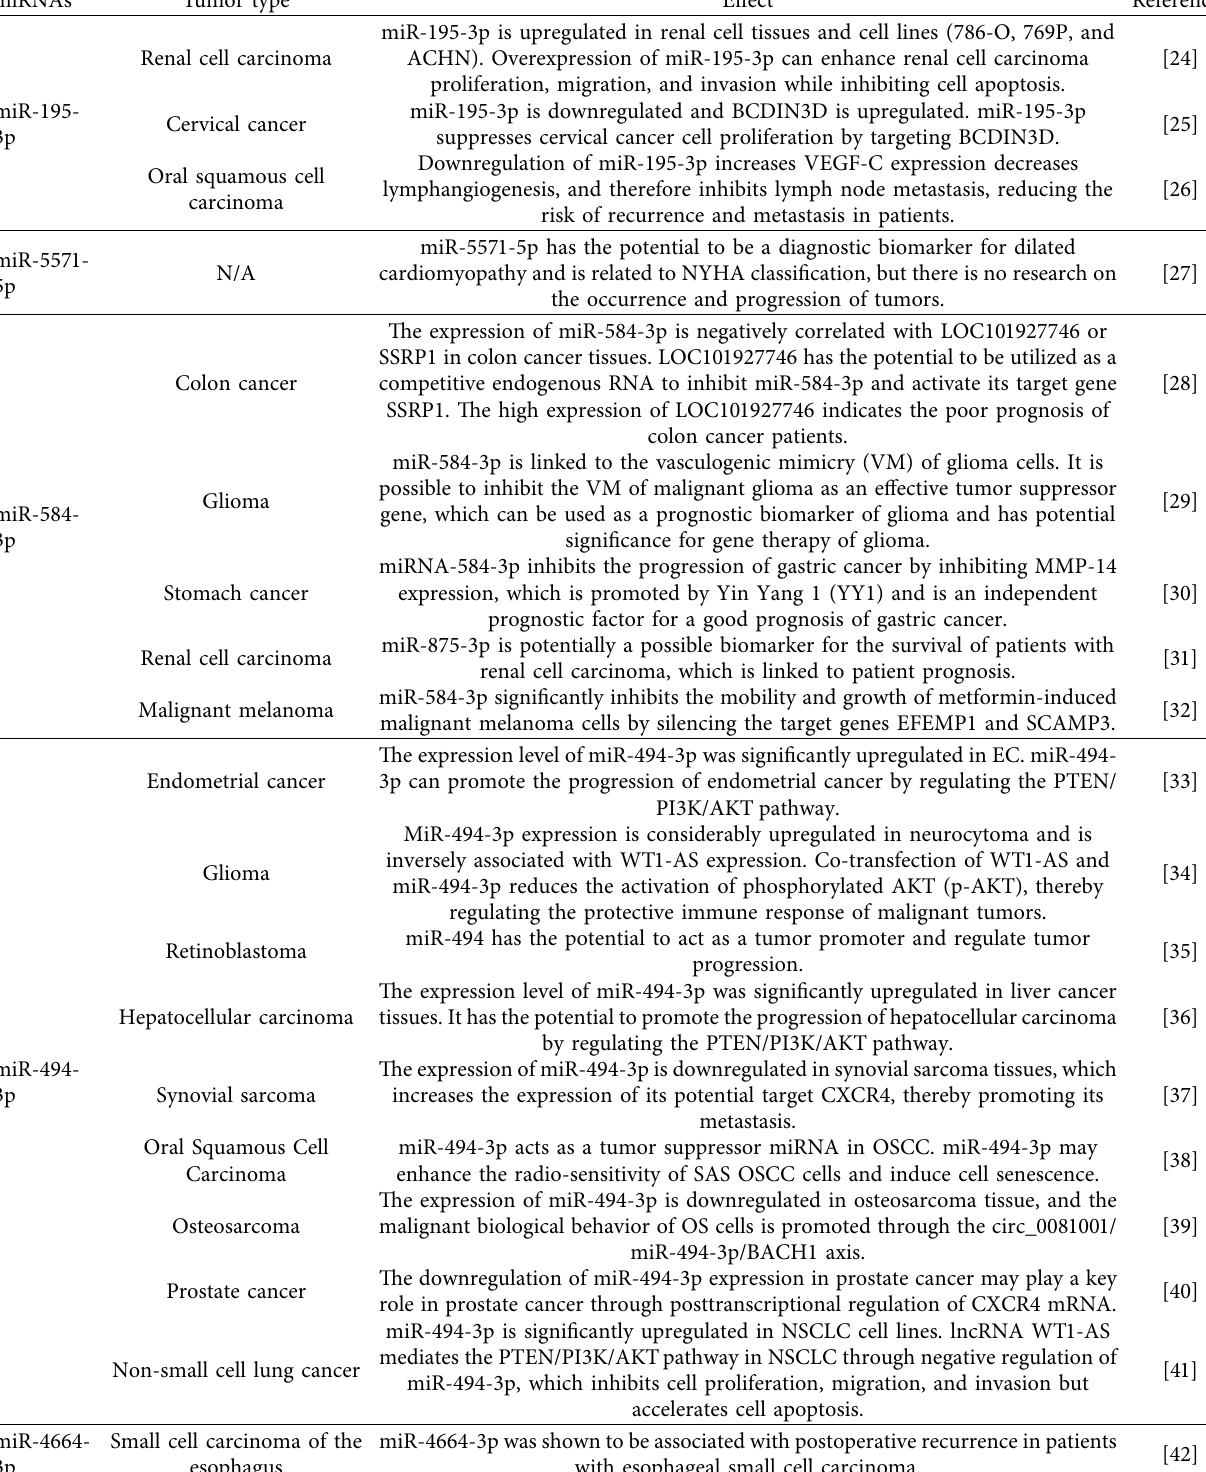
Table 2: The expression and role of six miRNAs in other